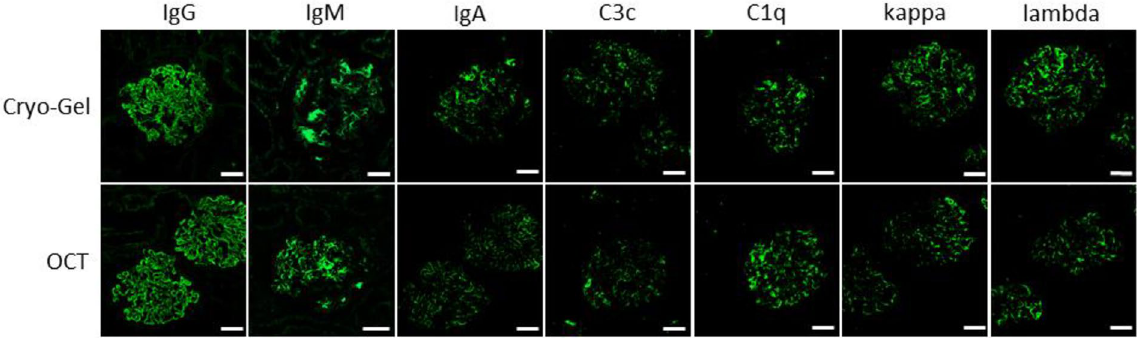
Figure 8. Immunofluorescence staining for IgG, IgM, IgA, C3c, C1q, kappa and lambda from renal cortex form a patient with lupus nephritis embedded in Cryo-Gel and OCT compound (magnification 20x; scale bar = 50 µ